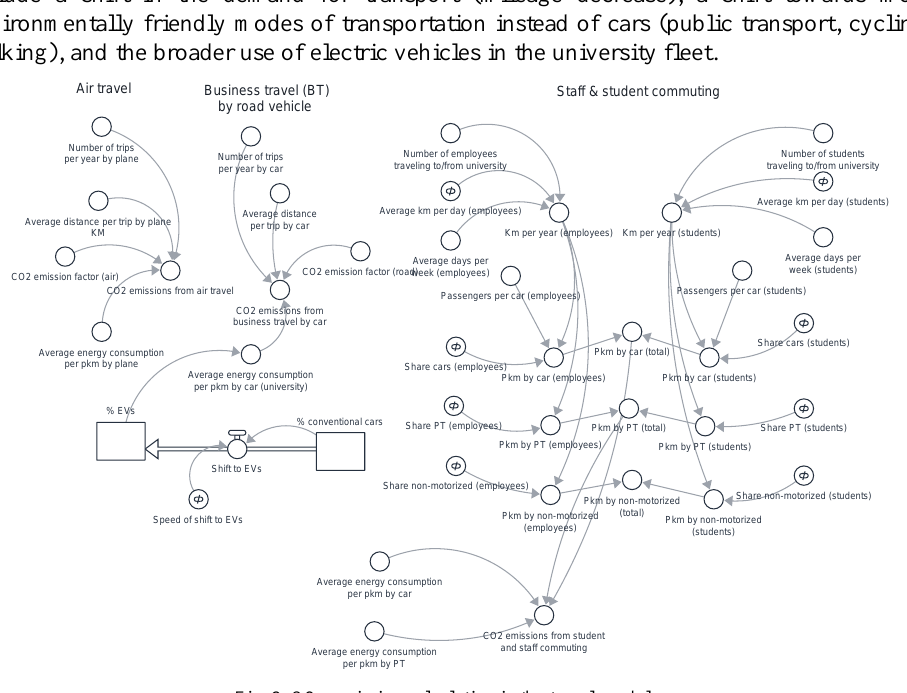
Fig. 2. CO 2 emission calculation in the travel